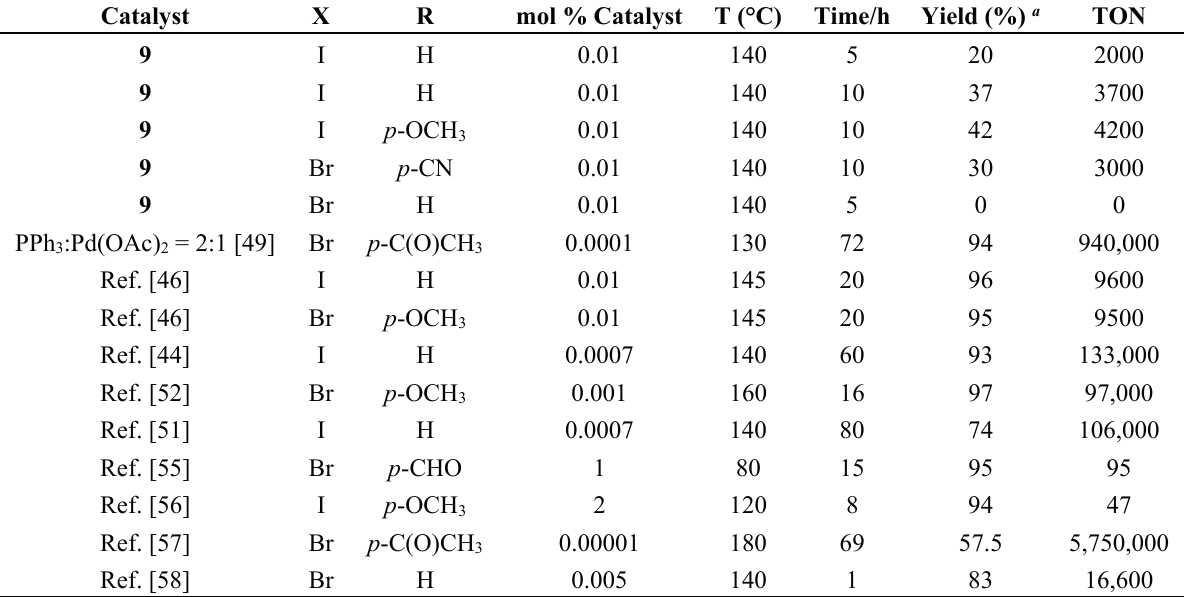
Table 2. Heck coupling reaction of aryl halides with styrene using 9 as catalyst and comparison with other data from the literature. a Isolated yield (our